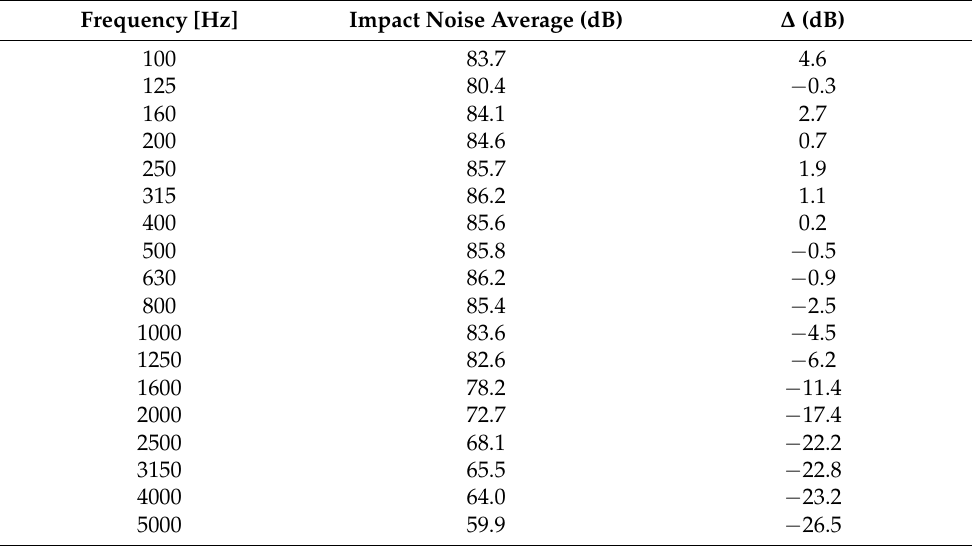
Table 4. Average trend and difference between measured and calculated values ( Δ ).